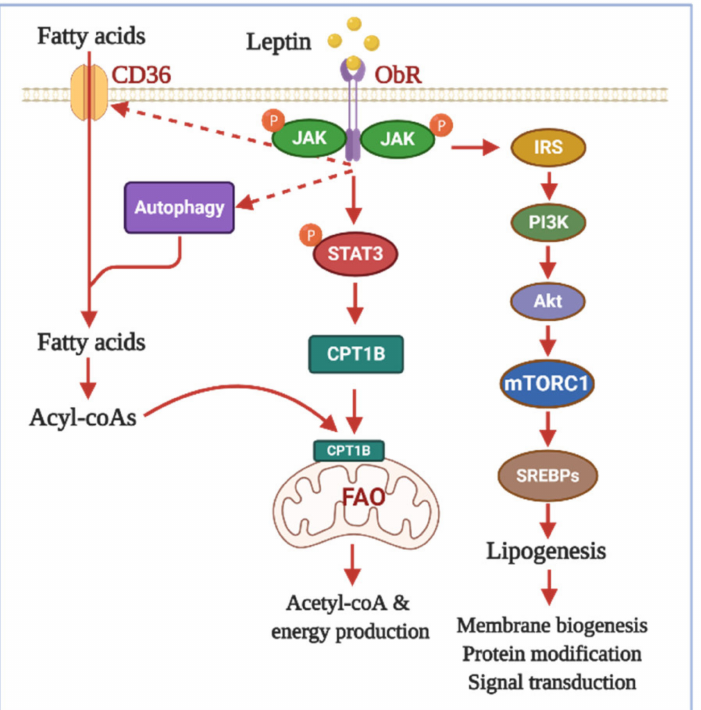
Figure 2. Leptin-promoted lipid metabolic reprogramming in cancer cells. Leptin modulates cancer cell specific lipid metabolism through concerted actions on biosynthesis, degradation, and uptake of fatty acids. On the one hand, leptin stimulates de novo fatty lipid biosynthesis through activation of SREBPs in a PI3K/Akt/mTORC1-dependent mechanism. Activation of lipogenesis by leptin